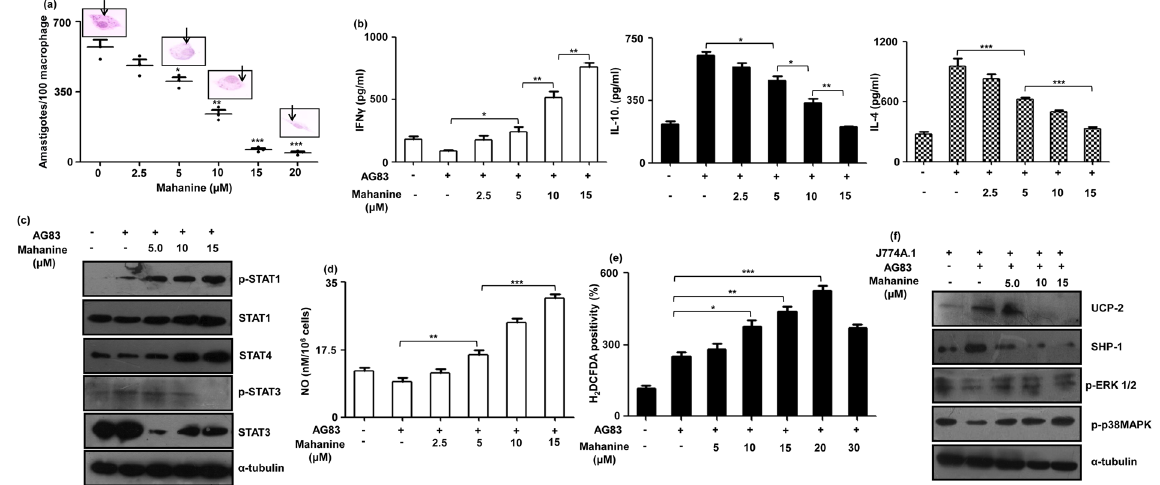
Figure 3. In vitro efficacy of mahanine. ( a ) Murine macrophage cell line J774A.1 (2 × 10 4 ) grown in 22mm 2 glass cover slip were infected with stationary phase virulent AG83 promastigotes (1: 10) for 4 hr. Unbound parasites were removed and infection was allowed for another 20 hr. Infected cells were treated with mahanine (0–20 µ M) for 24 hr. Macrophages were fixed and stained with Giemsa. Intracellular parasites were counted in a light microscope. The values represented as a mean of three independent experiments. A representative image was given as micro photo above the mean value. ( b ) Macrophages (J774A.1, 1 × 10 6 /well) were infected with stationary phase L. donovani (AG83) promastigotes similarly as stated above. The secreted cytokines (IL-4, IL-10, and IFN γ ) in the culture supernatants were measured by respective ELISA kit as described in material and methods. ( c ) J774A.1 cells (1 × 10 6 /well) were infected and treated similarly as stated above. The